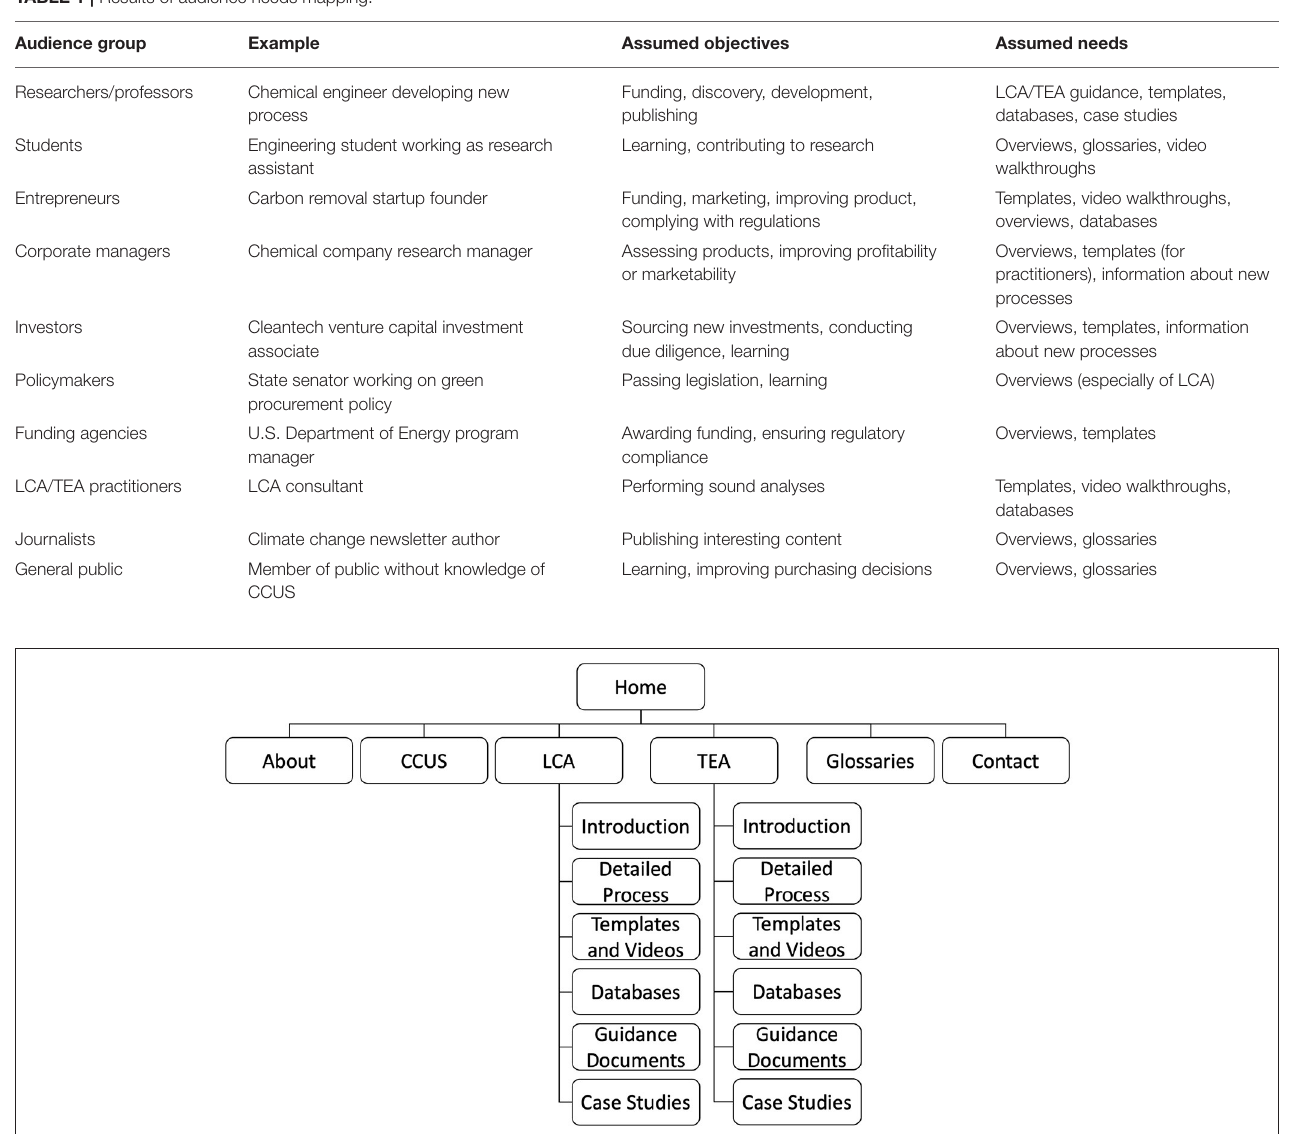
FIGURE 1 | AssessCCUS sitemap demonstrating hierarchy of pages featured on the